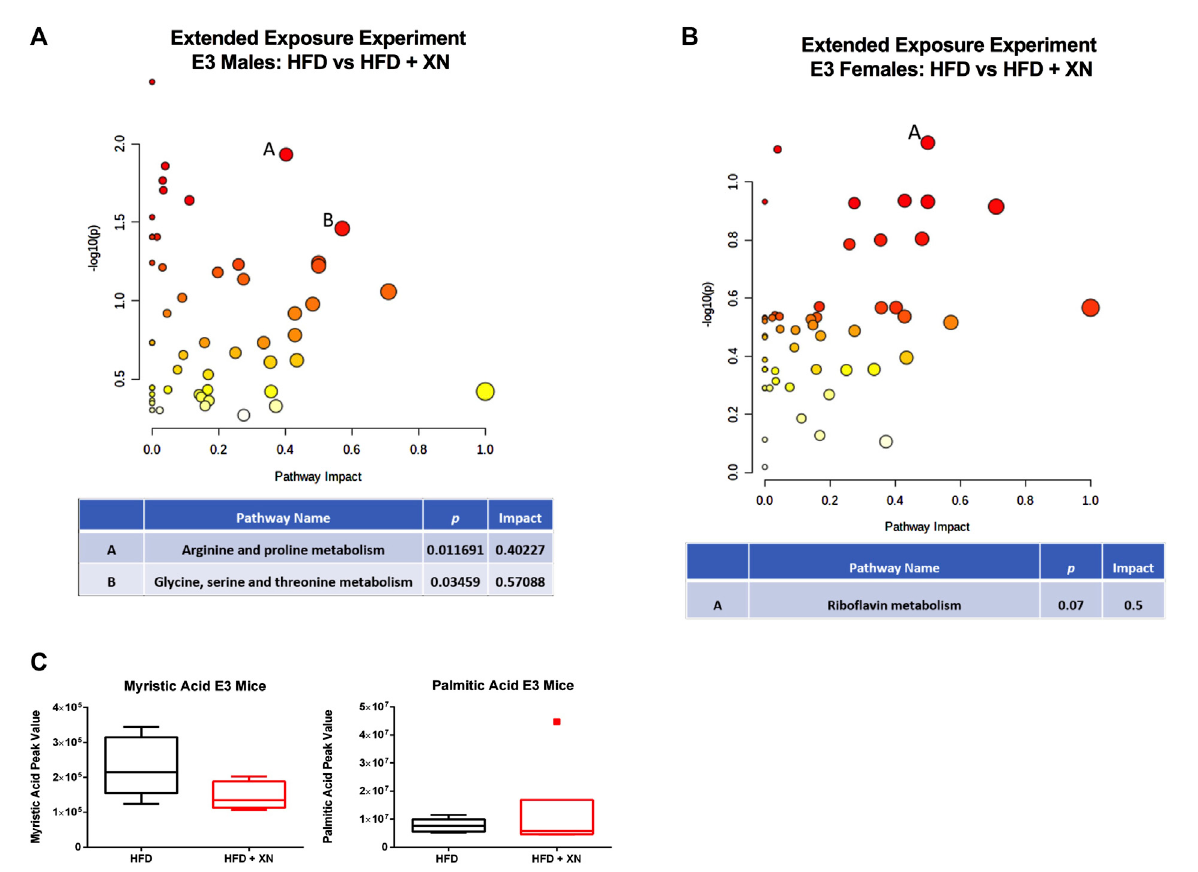
FIGURE 7 (A) MetabolicpathwaysaffectedbyXNinthehippocampusofE3malesintheextendedexposureexperiment.Signi fi cantlyalteredpathways( p < 0.05) and with an Impact factor > 0.3 are shown. (B) In E3 females, there was a trend towards the ribo fl avin metabolism being affected. (C) Myristic acid levels were reduced in XN-treated E3